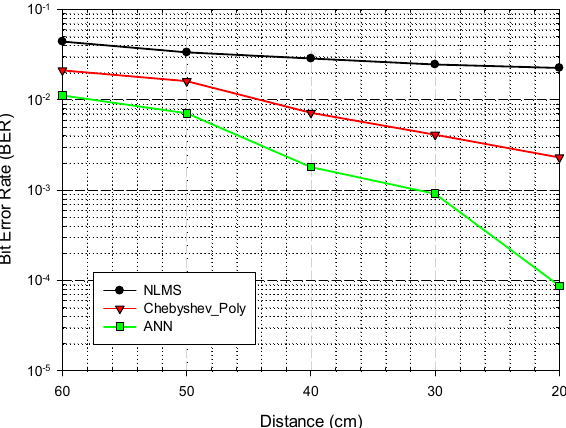
Figure 13. BER versus the distance between the LED and the PD of the 16 QAM modulated OFDM for the NLMS, the Chebyshev polynomial, and the proposed ANN predistortion.